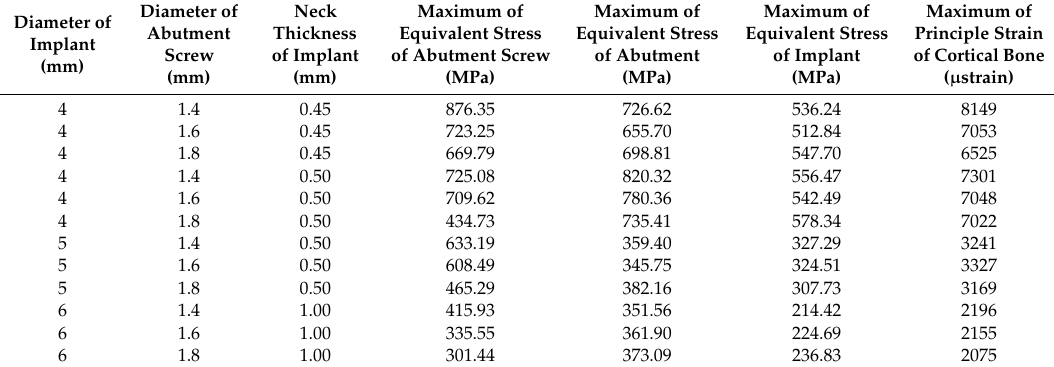
Table 3. Simulated results of maximum von Mises stress for the implant, abutment, and abutment screw and maximum first bone strain in all models.